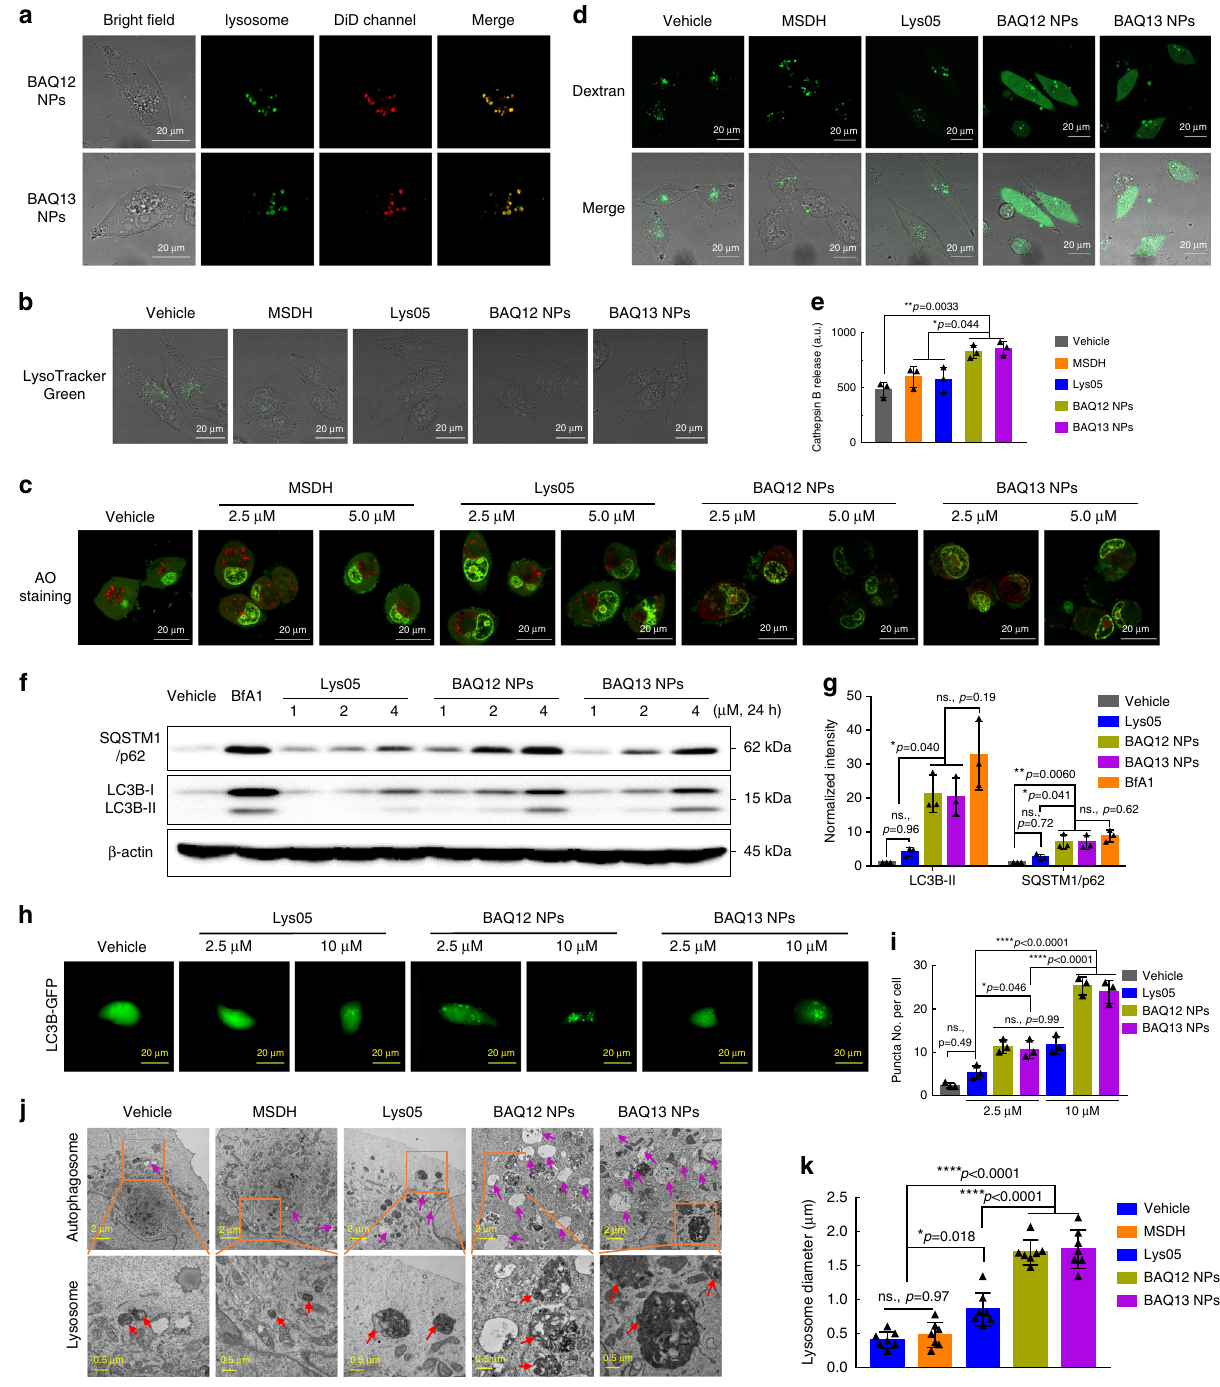
Fig. 3 BAQ ONNs induced lysosomal disruption and inhibited autophagy in MIA PaCa-2 cells. a Representative images for cellular uptake of nanoparticles; Dextran-AF488-loaded cells were incubated with DiD-labelled BAQ ONNs for 2 h; experiments were repeated three times independently. b Cells were treated as indicated (10 µ M, 2 h) and were stained by LysoTracker Green; experiments were repeated three times independently. c AO staining of cells within the indicated treatments (5 µ M, 12 h); experiments were repeated three times independently. d Representative images of Dextran- AF488-loaded cells that were treated as indicated (5 μ M, 12 h); experiments were repeated three times independently. e Cathepsin B release from isolated lysosomes after treatments as indicated (25 µ M, 12 h); data are presented as mean values ± SD; n = 3. f Western blotting. g Normalised quanti fi cation analysis of gel blots in f ; data are presented as mean values ± SD; n = 3. h Representative LC3B-GFP images for the indicated 4 h treatments; experiments were repeated three times independently. i Quanti fi cation of LC3B-GFP puncta per cell in h ; data are presented as mean values ± SD; n = 3. j Representative TEM images of cells that were treated as indicated (2 µ M, 48 h); orange rectangle: region of interest; purple arrows: autophagic vesicles; red arrows: lysosomes. k The average diameter of lysosomes; data are presented as mean values ± SD; n = 7. All statistical p values were calculated by one-way ANOVA with the Tukey ’ s multiple comparison test. ns., not signi fi cant; * p < 0.05; ** p < 0.01; **** p <